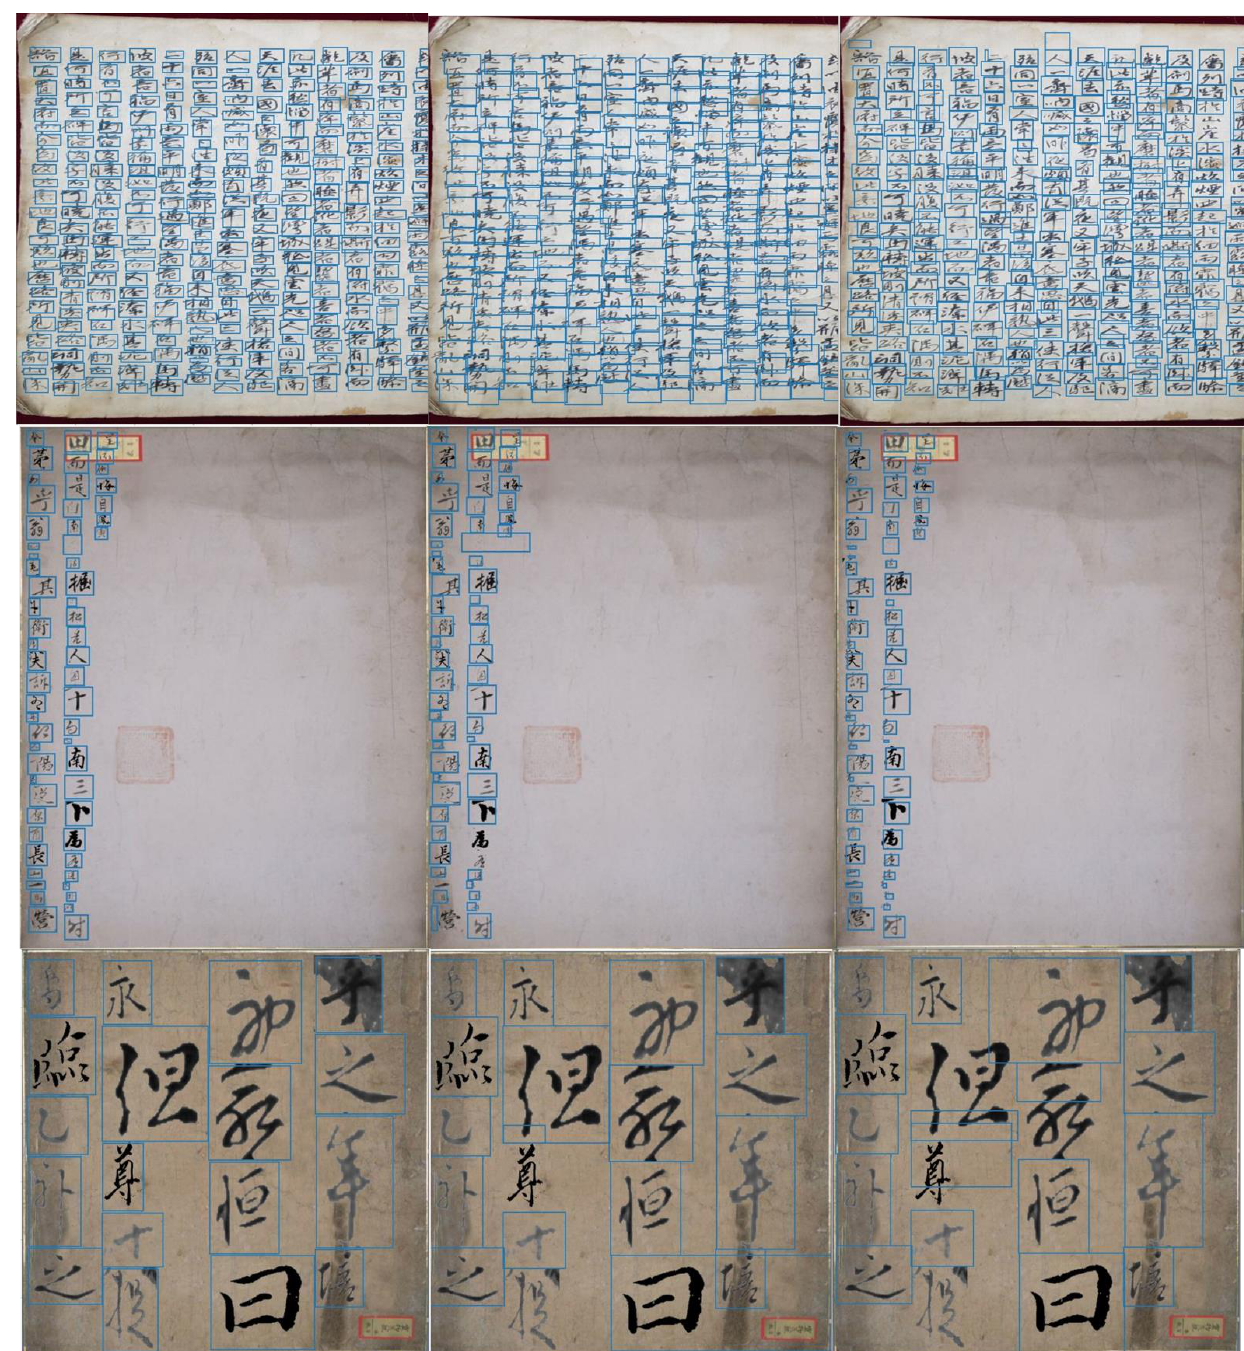
Figure 7. Visualization comparisons of three different models. From the left column to the right column, FC-MSCCD, CCB-SSD, and A human-inspired recognition system. In our benchmark, the first row shows detection results for the Caoshu dataset, the second row shows detection results for the Character dataset, and the last row shows detection results for the Src-image dataset. We used a merged dataset in our experiments.